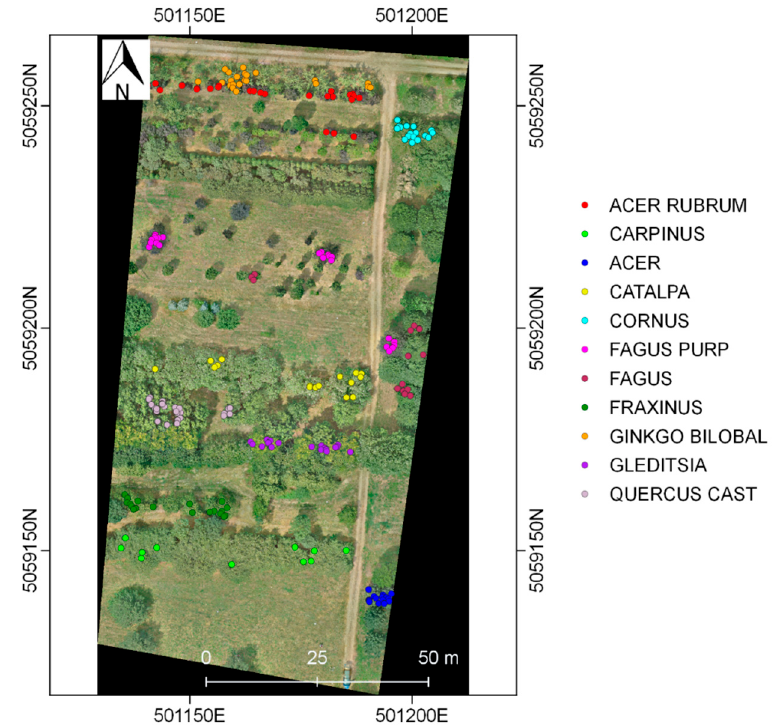
Figure 5. Centroids of the reference polygons used for classification purposes.